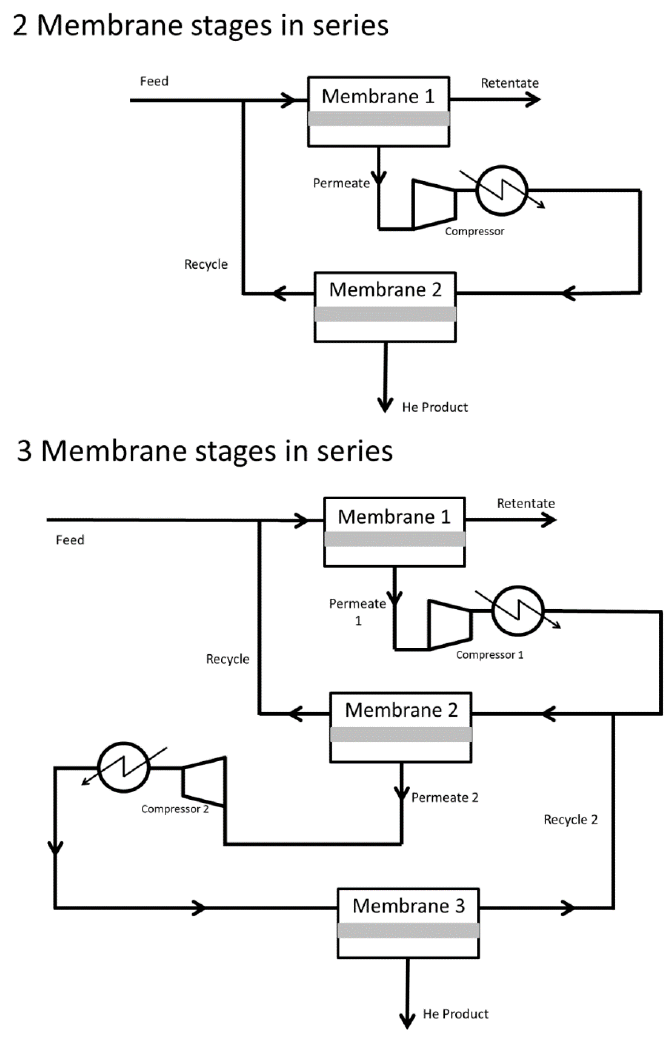
Figure 2. Process diagram example of two and three membrane stages processes, with recycle streams, recovering helium.